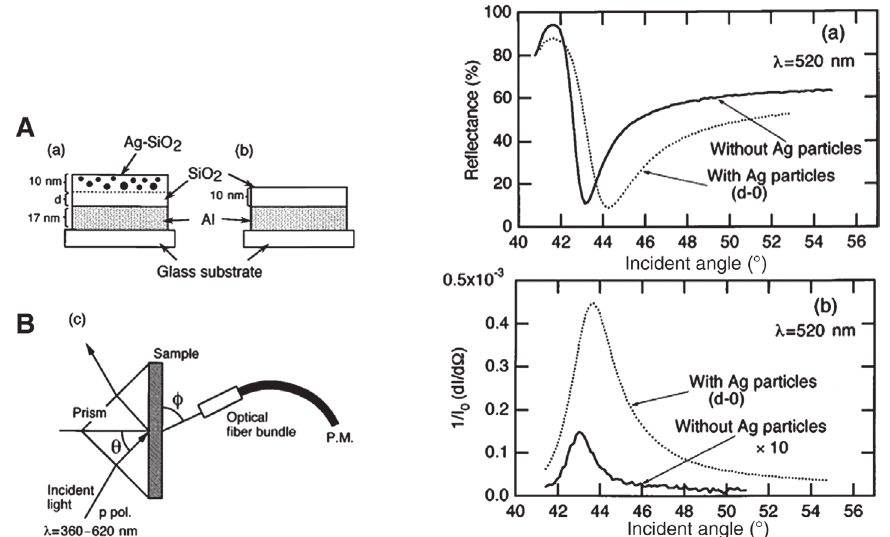
Figure 6: (A) and (B) Geometry of the samples in the experiment of Kume et al. [27]. (c) Experimental arrangement for measurements of light emission under PSP excitation. (C) ATR spectra and (D) dependences of emitted light for the sample with (d-0) and without Ag particles. The emitted light was measured fixing the observation angle of 90 ° . The wavelength of the incident light was set to 520 nm. Reprinted figure with permission from T. Kume, S. Hayashi, and K. Yamamoto, Phys. Rev. B, 55, 4774–4782, 1997. Copyright (1997) by the American Physical Society.